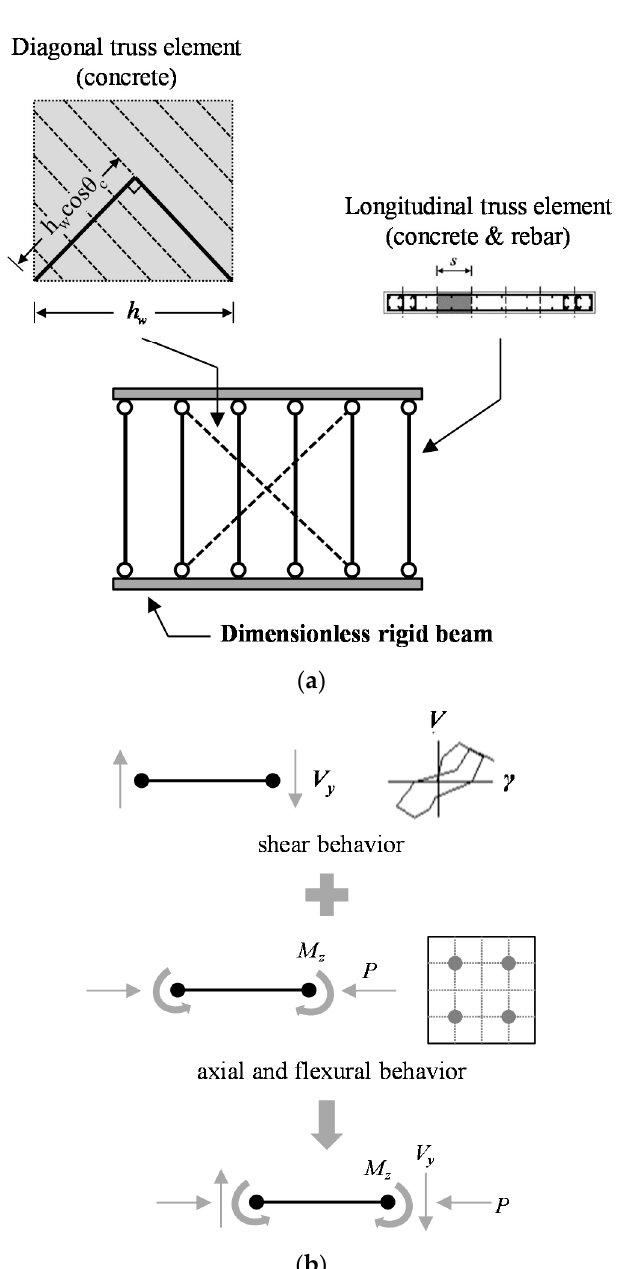
Figure 11. Analytical modeling approach: ( a ) longitudinal and diagonal line element model (LDLEM) modeling (Park and Eom, 2007); ( b ) Section aggregator.